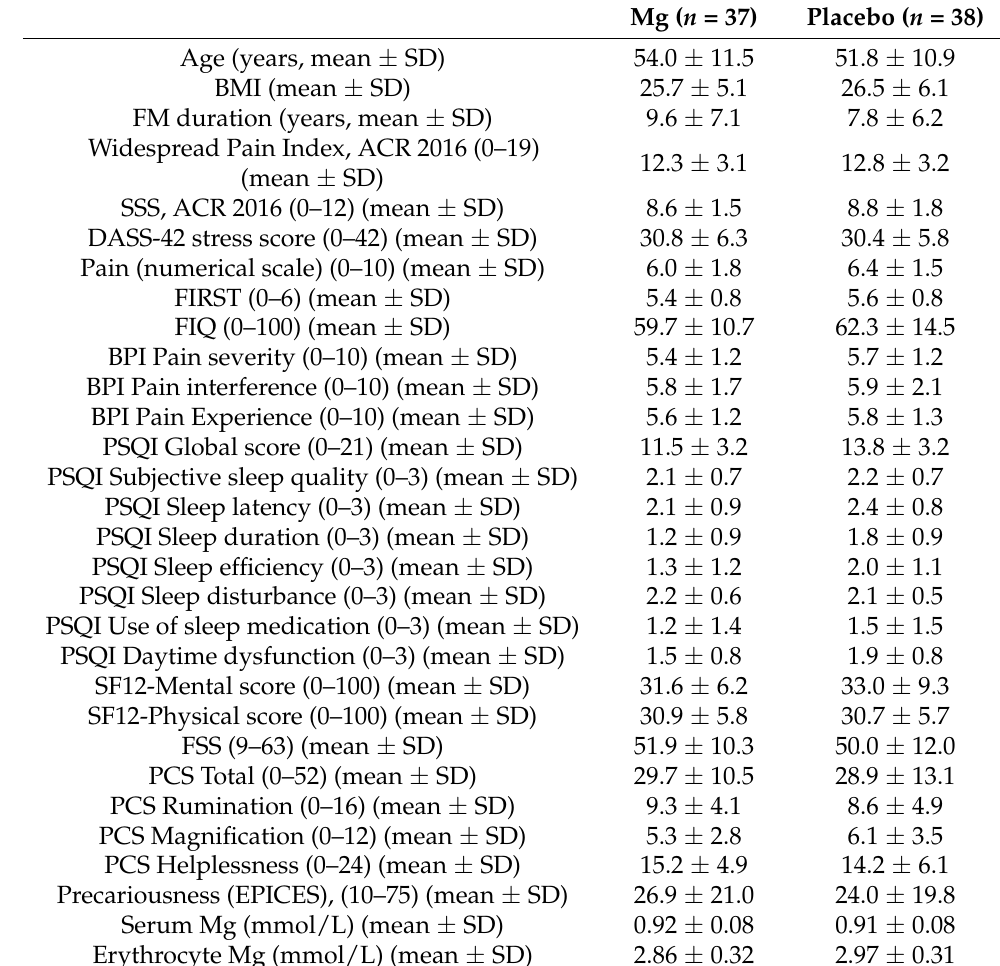
Table 1. Baseline characteristics of patients with FM ( n =